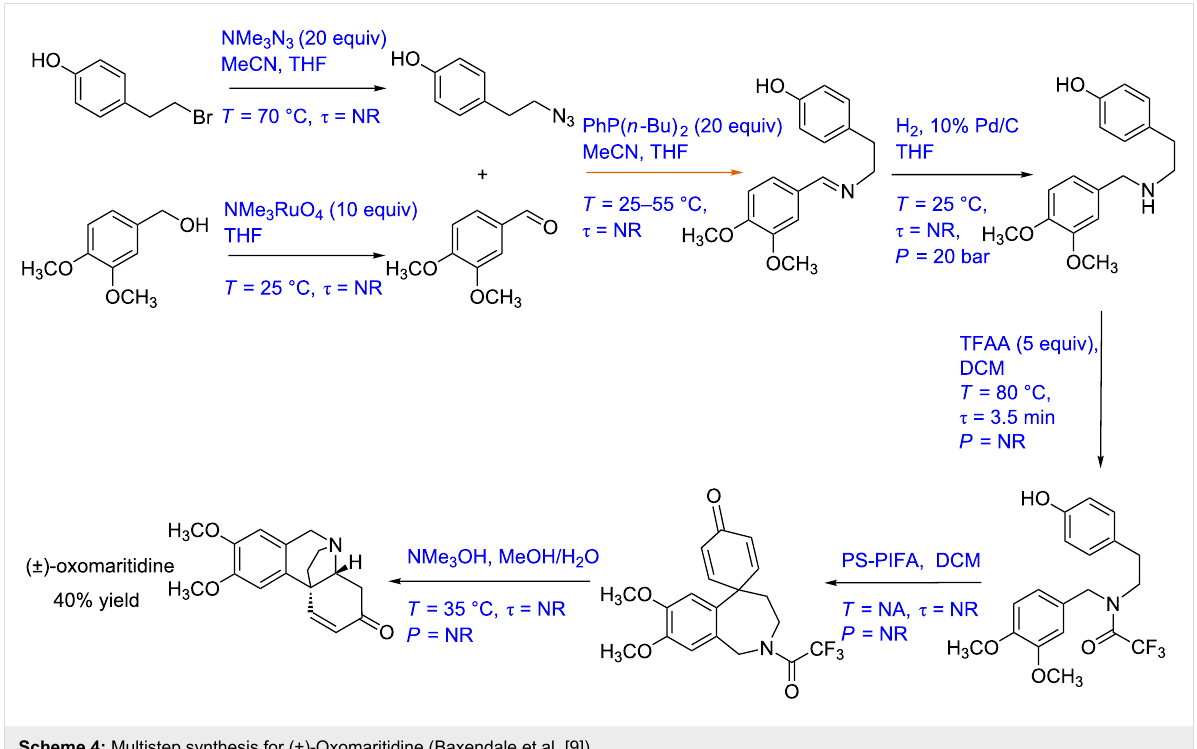
Scheme 4: Multistep synthesis for (±)-Oxomaritidine (Baxendale et al.